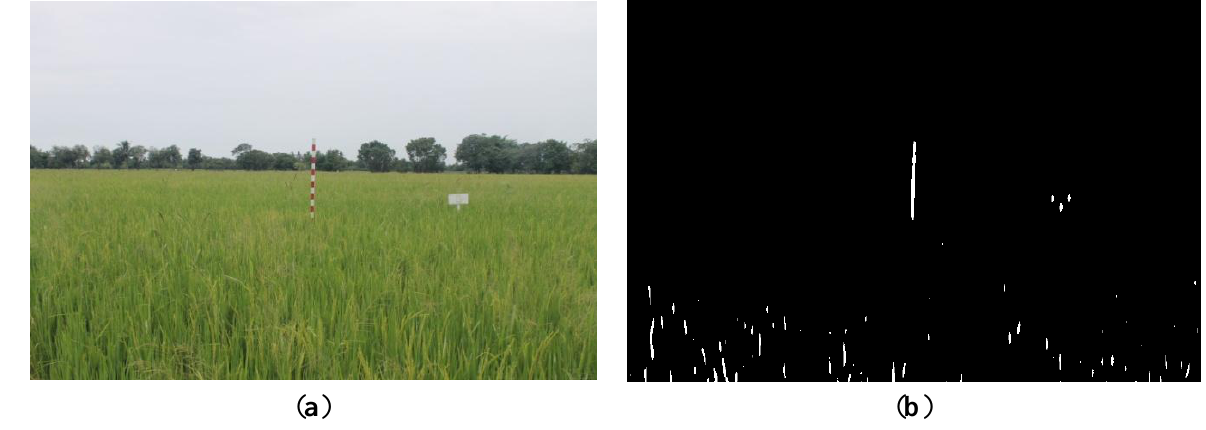
Figure 19. Comparison between ( a ) RGB and ( b ) resultant binary images using proposed method with red band feature on 18 July 2012.